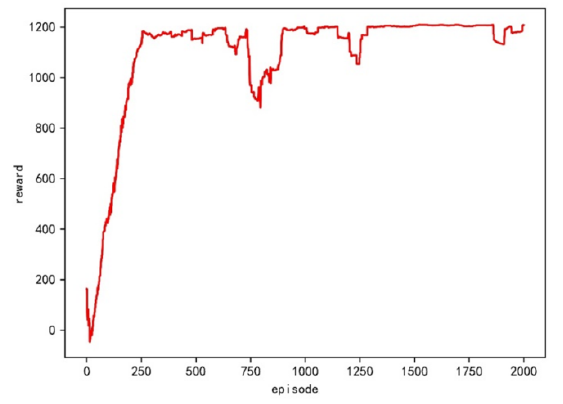
Figure 11. Reward when 𝑤 = 0.7.